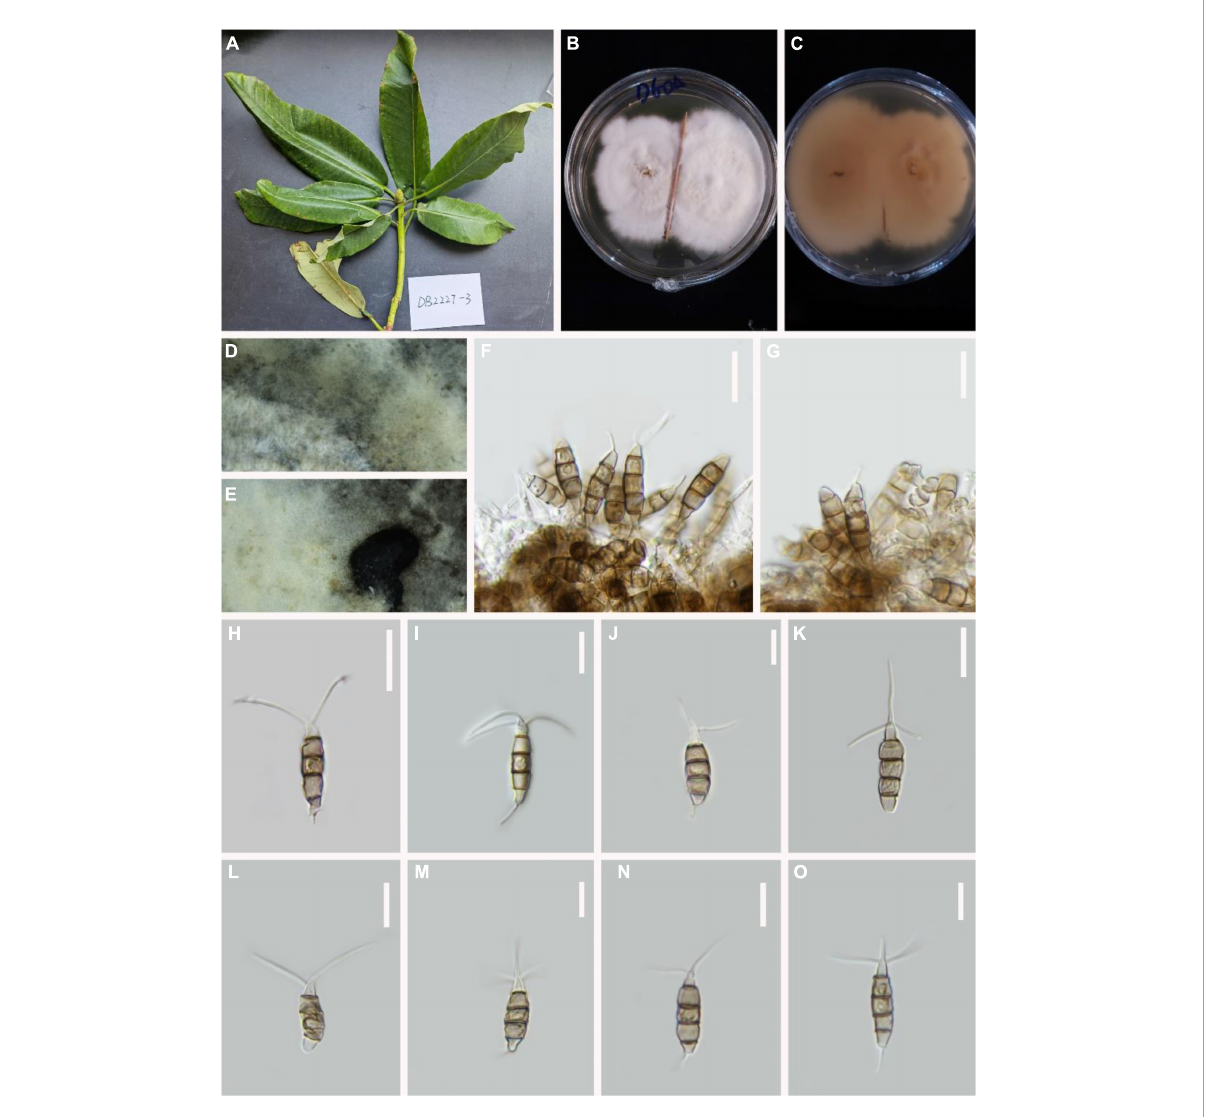
FIGURE2 Pestalotiopsis appendiculata (KUN-HKAS 124571, holotype). (A) Leaves of Rhododendron decorum . (B,C) Culture on potato dextrose agar (PDA) (upper and lower view). (D,E) Conidiomata on PDA. (F,G) Conidiophores, conidiogenous cells, and conidia. (H–O) Conidia. Scale bars: (F) 15 µ m,